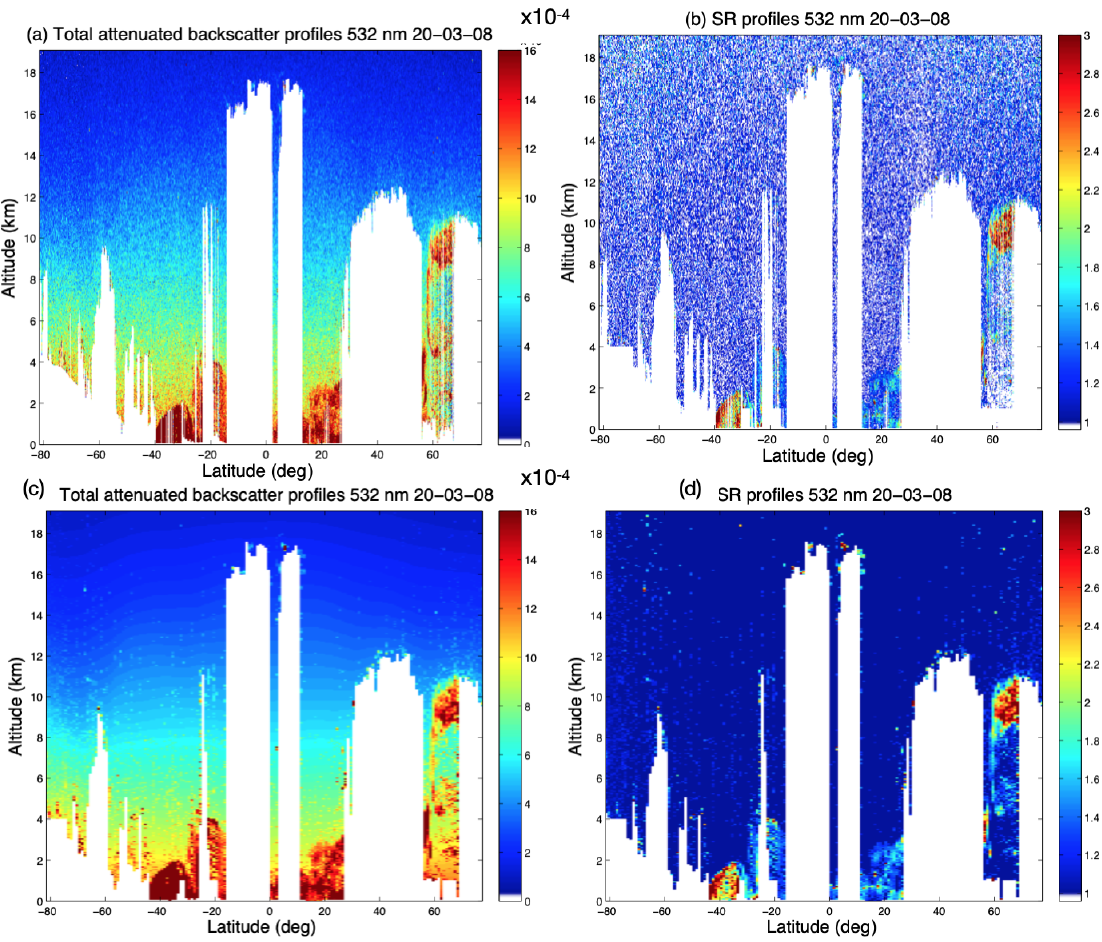
Figure 2. Attenuated total backscatter profiles (km − 1 sr − 1 ) before noise filtering (a) and after noise filtering (c) ; backscatter ratio profiles before noise filtering (b) and after noise filtering (d) ; observed by CALIOP at 532nm along the satellite orbit on 20 March